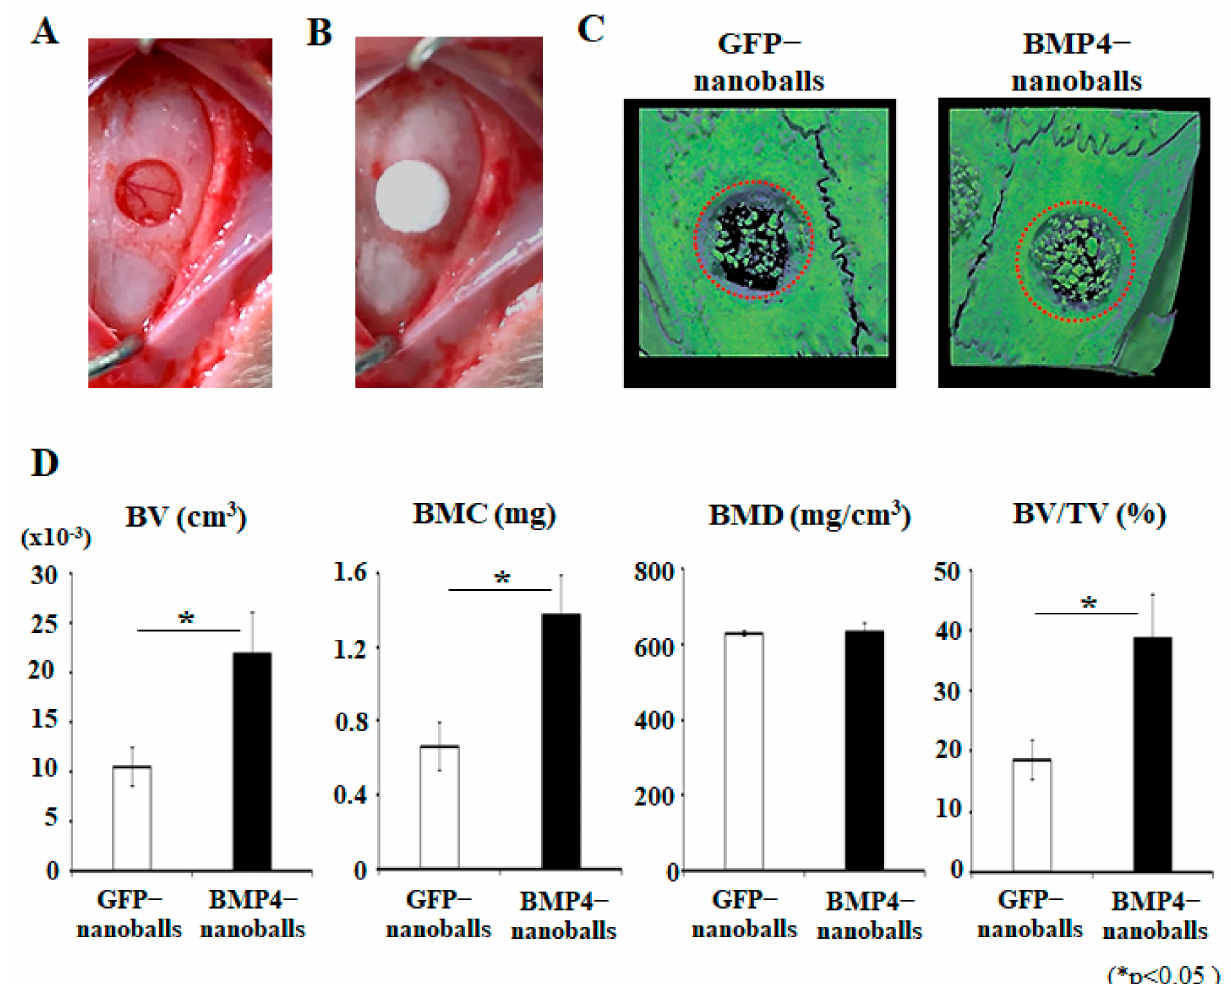
Figure 3. Biological function of BMP4-nanoballs in vivo. ( A ) A photograph of a created bone defect (4 mm in diameter) in rat cranium. ( B ) A photograph of BMP4-nanoballs (5 µ g) transplantation with a scaffold (4 mm in diameter and 1.5 mm in thickness). ( C ) Representative reconstructed micro-CT images of specimens at 4 weeks post-transplantation. BMP4- nanoballs enhanced the bone reconstruction compared with GFP-nanoballs. Red dotted circle, original size of bone defect. ( D ) Quantification of bone reconstruction in defective sites treated with nanoballs. Bone volume (BV), bone mineral content (BMC), bone mineral density (BMD), and bone volume/tissue volume (BV/TV) were analyzed ( n = 3, * p <